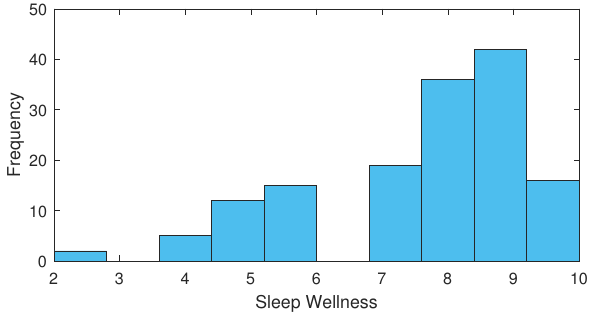
Figure 10. Wellness During Experiment Good Habits.